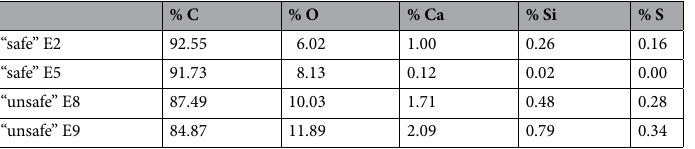
Table 1. Chemical composition of the surface of “safe” and “unsafe” Eppendorf-type tubes was obtained through XPS